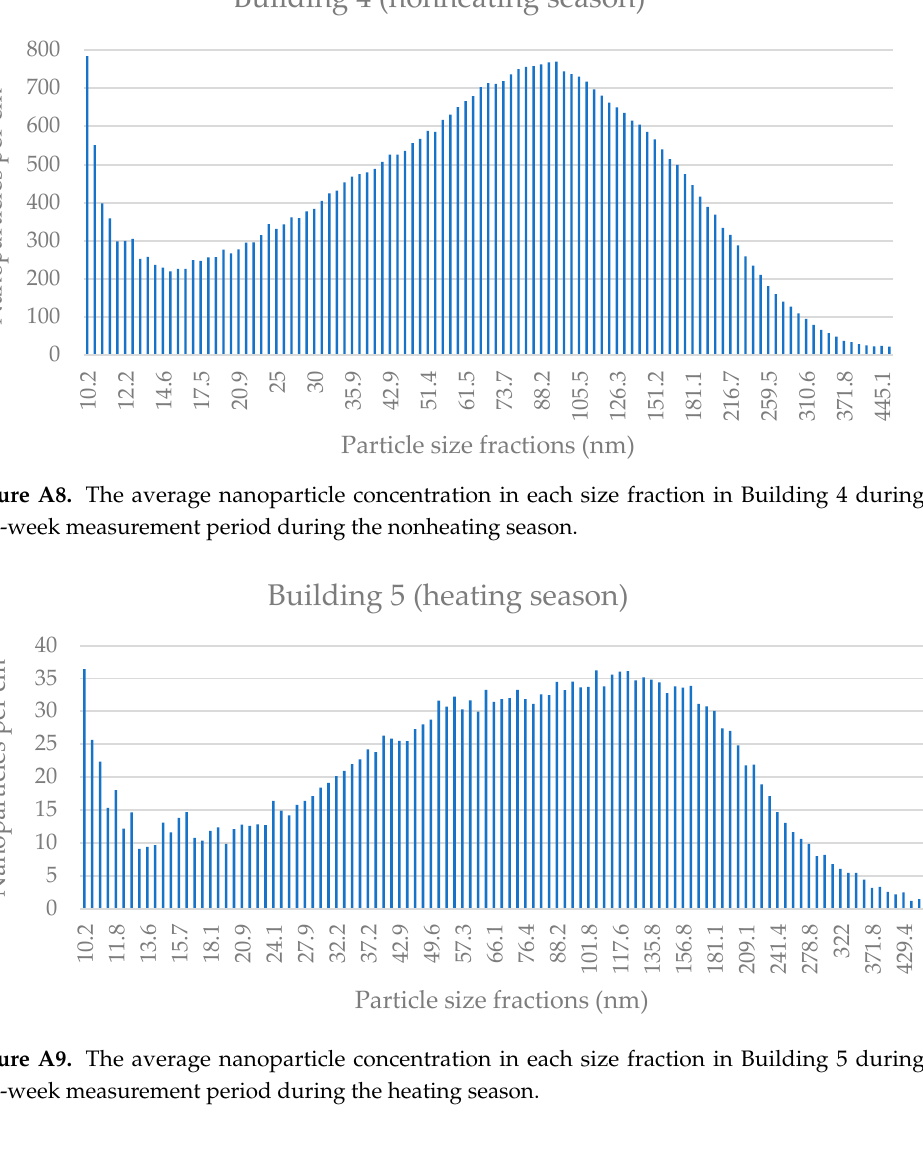
Figure A7. The average nanoparticle concentration in each size fraction in Building 4 during a one- week measurement period during the heating season.